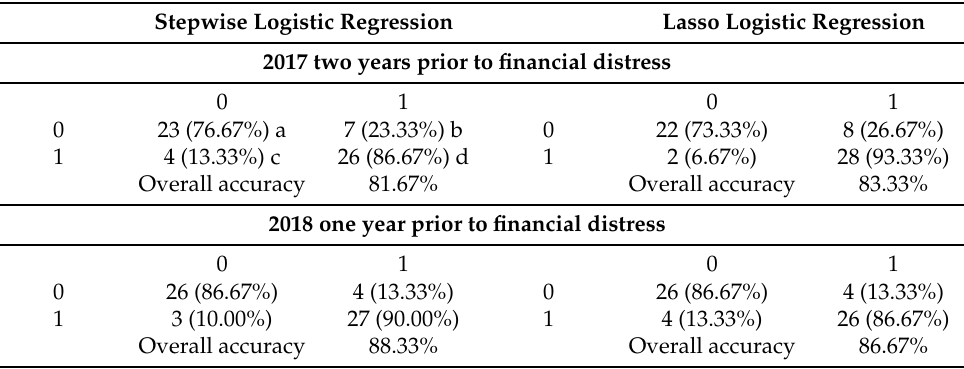
Table 8. Confusion matrices for neural networks models, years: 2017–2018. Stepwise Logistic Regression Lasso Logistic Regression